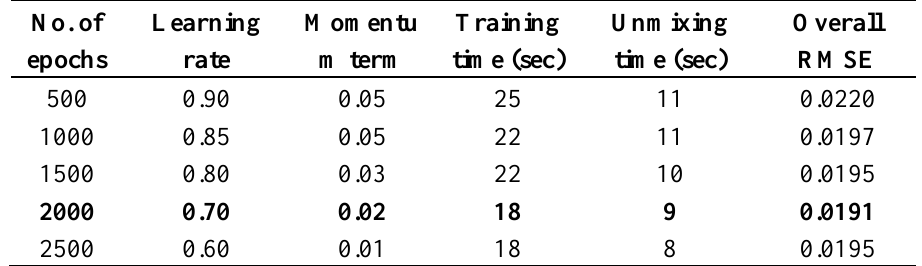
Table 3. Details of training for unmixing of MODIS images.